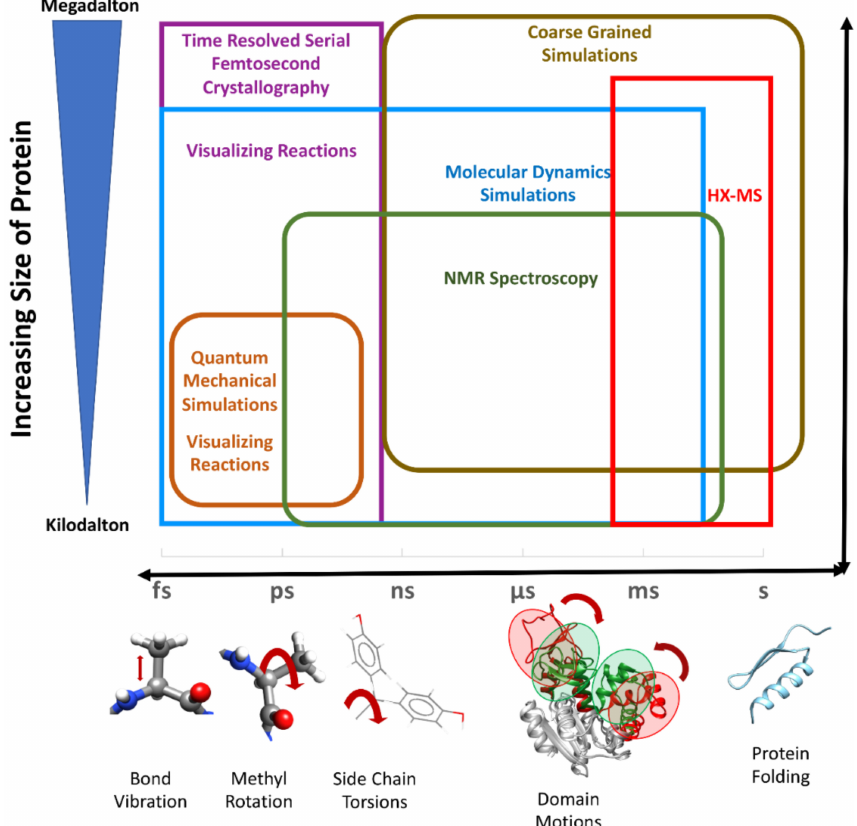
Figure 2. Protein dynamics can be modeled at several length and time scales. Various experimental and computational methods (shown in same colored text and boxes) are used to understand the multiscale dynamics of proteins and their complexes. Red arrows show different motions in the molecules happening at femtosecond (fs), picosecond (ps), nanosecond (ns), microsecond ( µ s) and millisecond (ms) time scale. Protein folding can have a time scale of seconds (s) to minutes or even